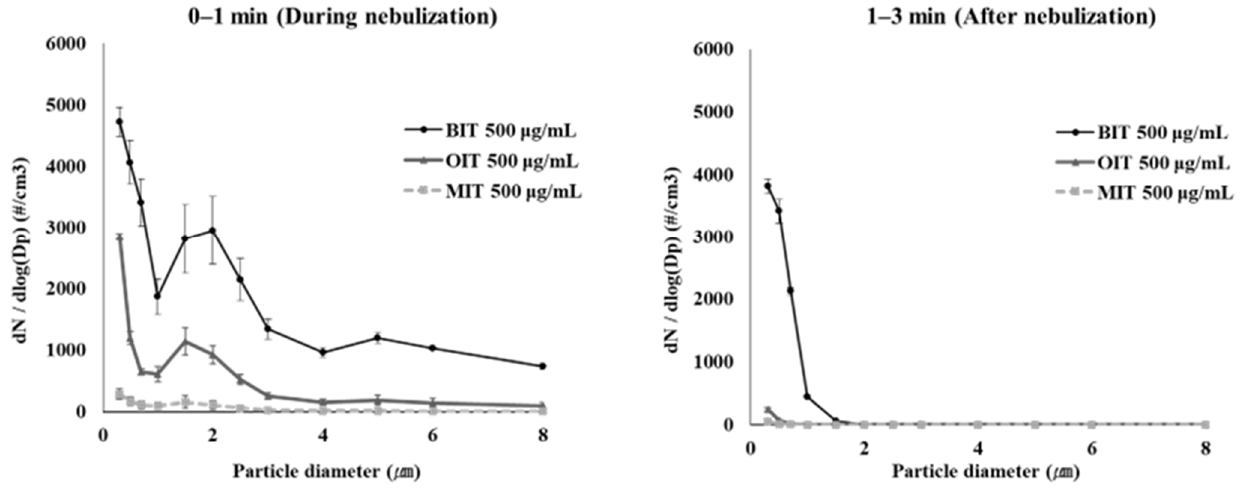
Figure 5. Particle distribution of BIT, OIT and MIT aerosols (at 500 μ g/mL) in number were measured in an in-house-built exposure chamber.